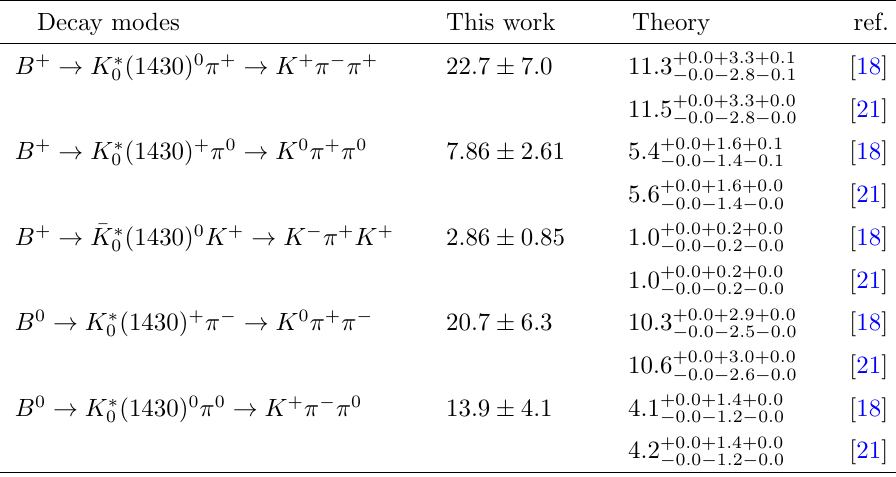
Table 8 . Comparison of the PQCD predictions with the theoretical results for the relevant quasi- two-body branching fractions (in units of 10 (cid:0) 6 ). The errors of this work have been added in